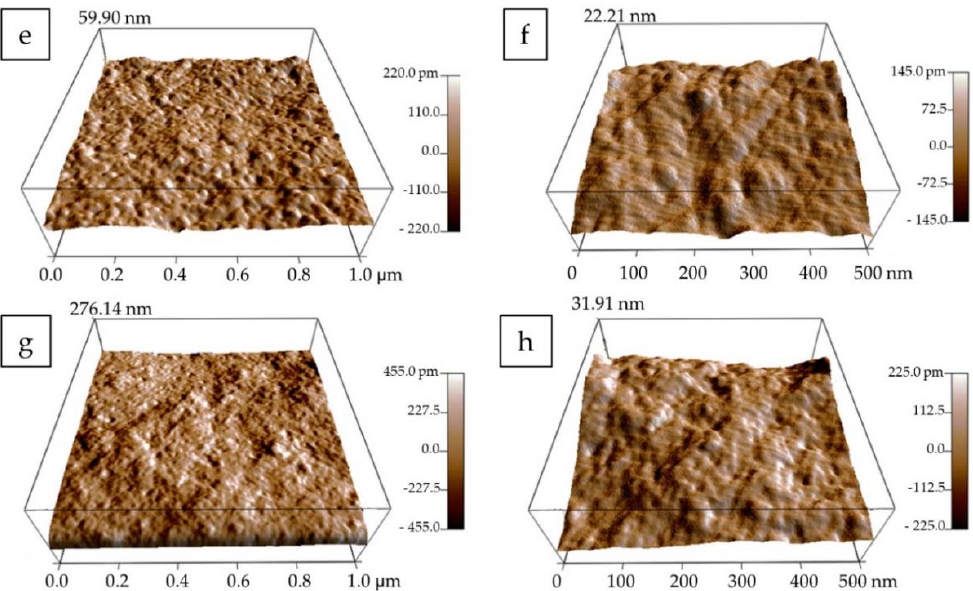
Figure 2. TEM pictures of NPc ( a , b ) and NPg ( c , d ). Scale bar: 500 nm. AFM images of NPc ( e , f ) and NPg ( g , h ).